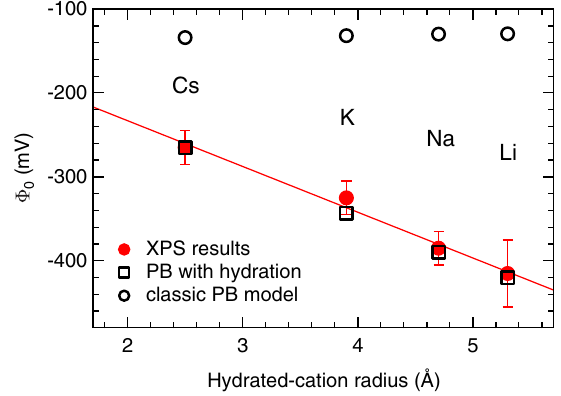
FIG. 6. Surface potentials at the silica NP-electrolyte interface. Red, solid circles: Results from XPS measurements. The solid line is a linear fit to the experimental data. Black, open squares: Prediction from the hydration-modified PB model. Black, open circles: Prediction from the Grahame equation based on the classic PB model.